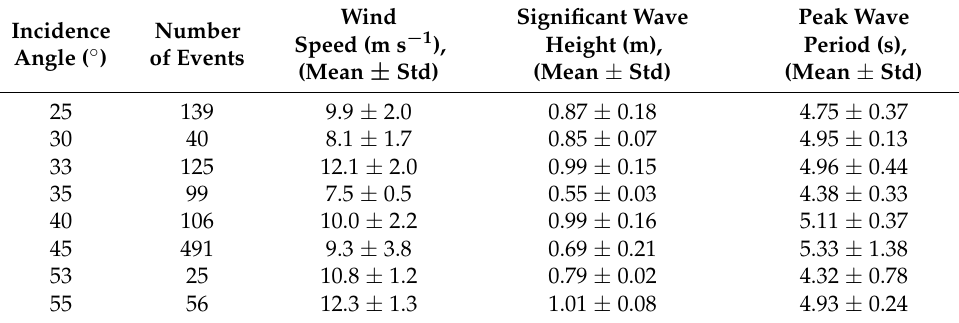
Figure 2. Histogram of breaker and environment characteristics for all breaking events: ( a ) wind speed, ( b ) significant wave height, ( c ) breaking crest speed, and ( d ) length. Table 1. Dataset